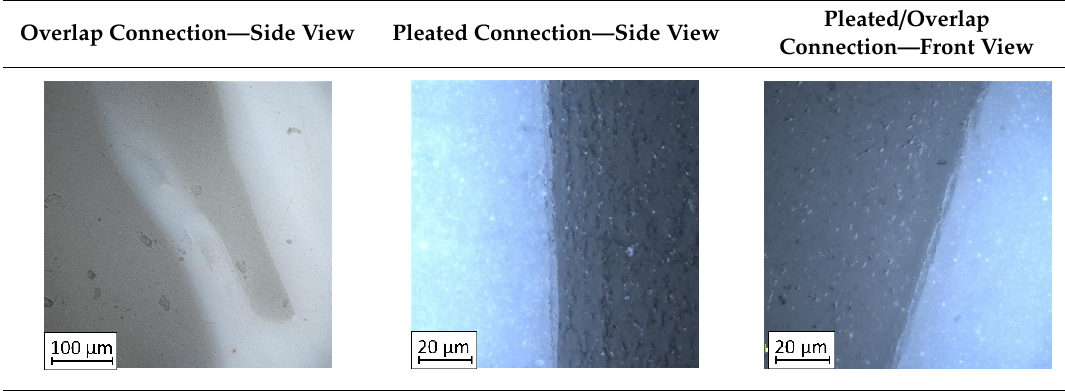
Table 2. The microstructure of the designed joints.